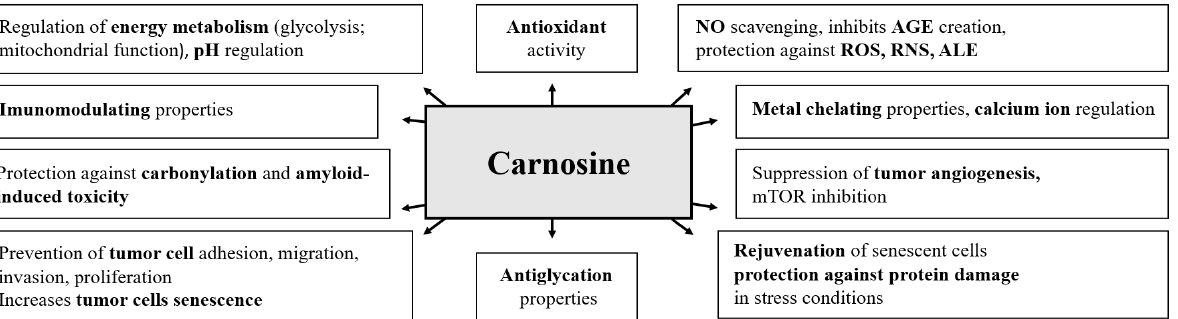
Figure 2. Biological activities of carnosine, simpli fi ed. ALE: advanced lipoxidation end products; AGE: advanced glycation end products; mTOR: mammalian target of rapamycin; NO: nitric oxide; RNS: reactive nitrogen species; ROS: reactive oxygen species. Additional information on carnosine’s molecular functions can be found in Supplementary Table S1.